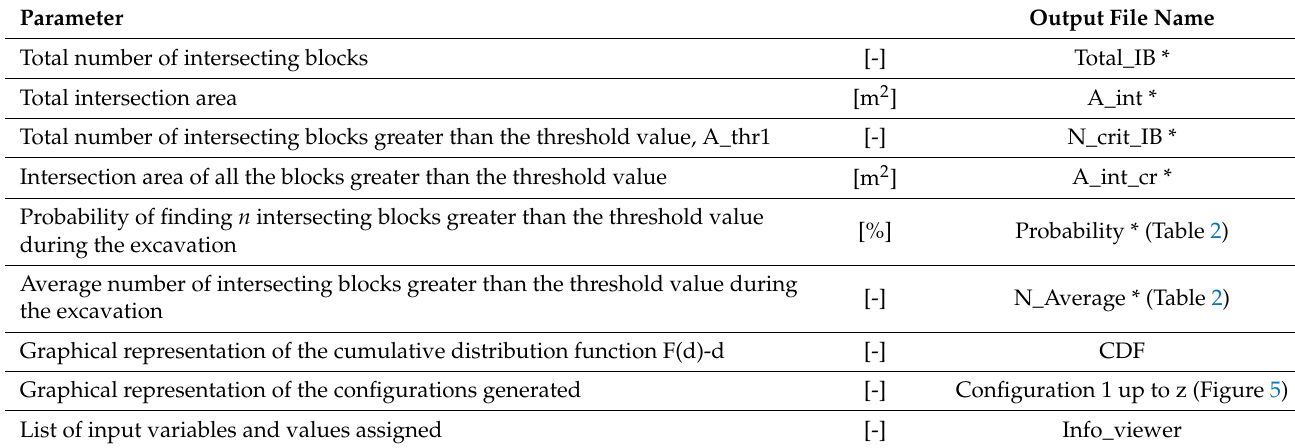
Table 3. Outputs of the executable code. The output files with the “*” contain the results related to both the entire tunnel section and the circular